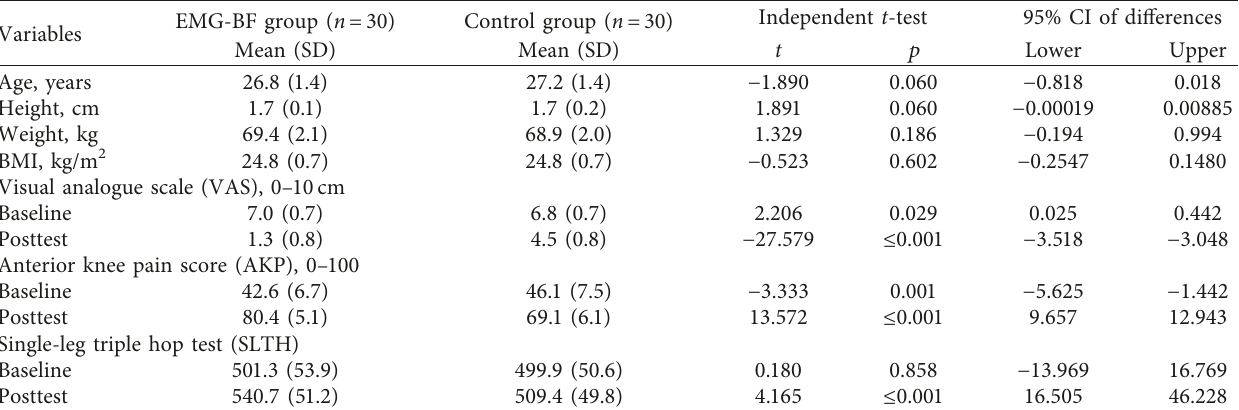
Table 1: Demographics details.